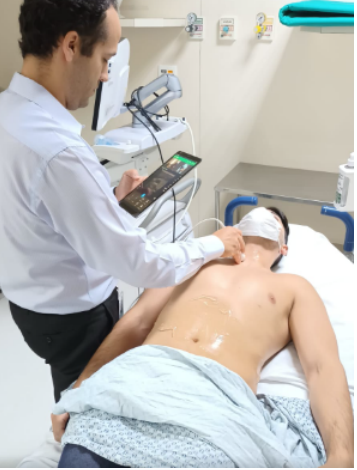
Figure 16. Doctor 1 performing ultrasound on the